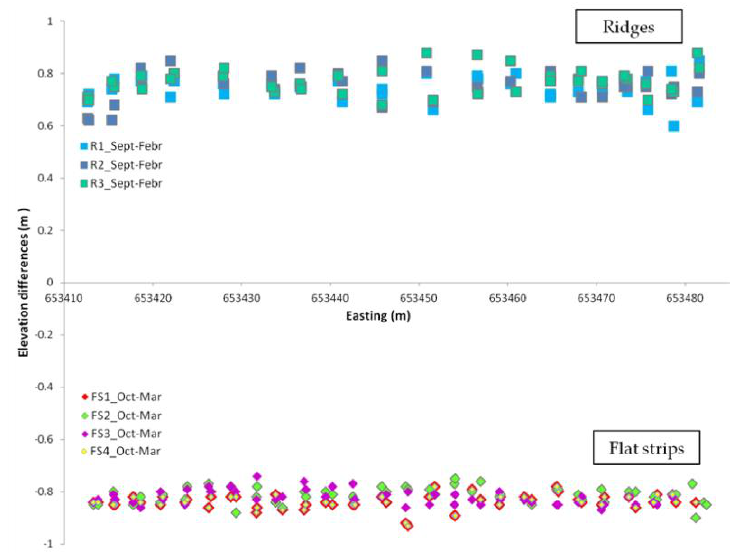
Figure 10. Elevation differences for each ridge (R) before and after the extreme rainfall event (September and February, respectively) and the elevation difference for each flat strip (FS) before and after the extreme rainfall event (October and March, respectively).